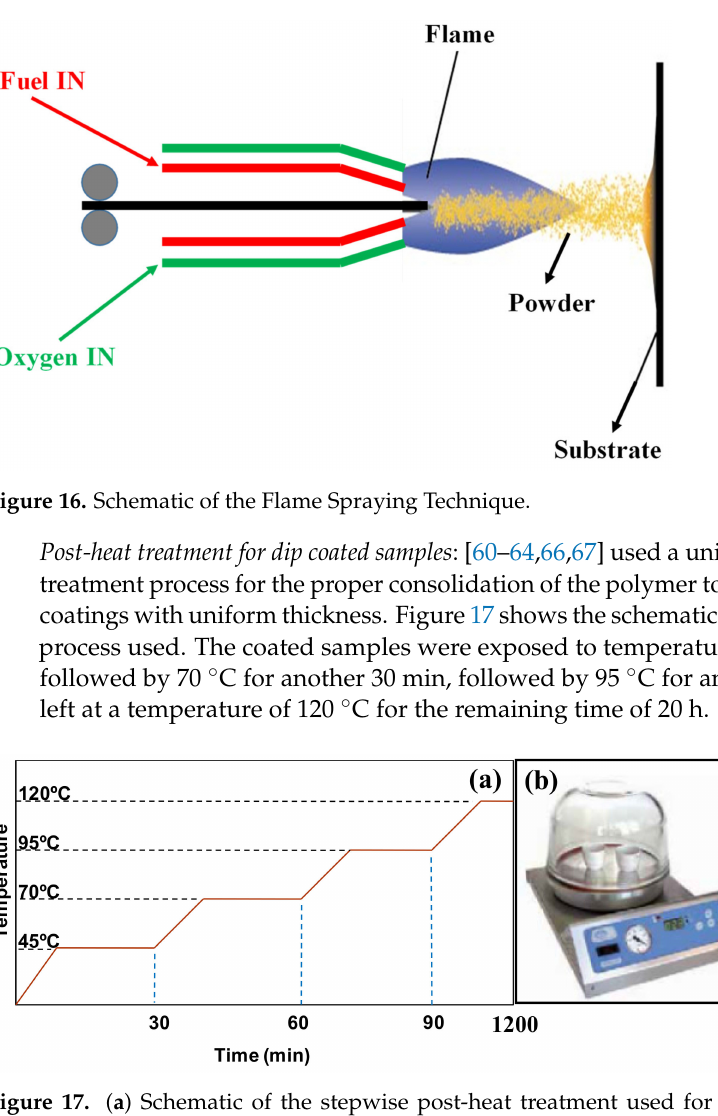
Figure 15. Schematic of the Electrostatic Spraying Technique.